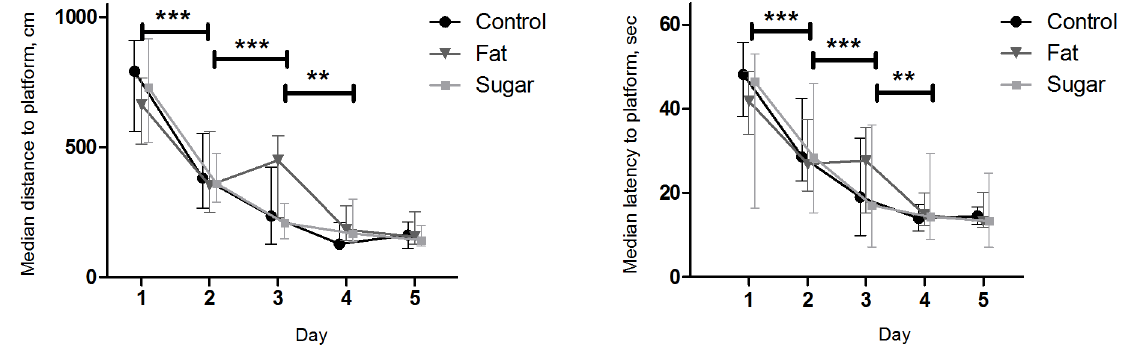
Figure 4. The Morris water maze test, distance swum and latency to reach the platform. A general day to day significant decrease in distance swum and latency to reach platform was seen for all diet groups, indicating that all diet groups learned the task. However, a high-fat diet seemed to influence negatively on coping with the start position sequence on day three. Median with ranges.